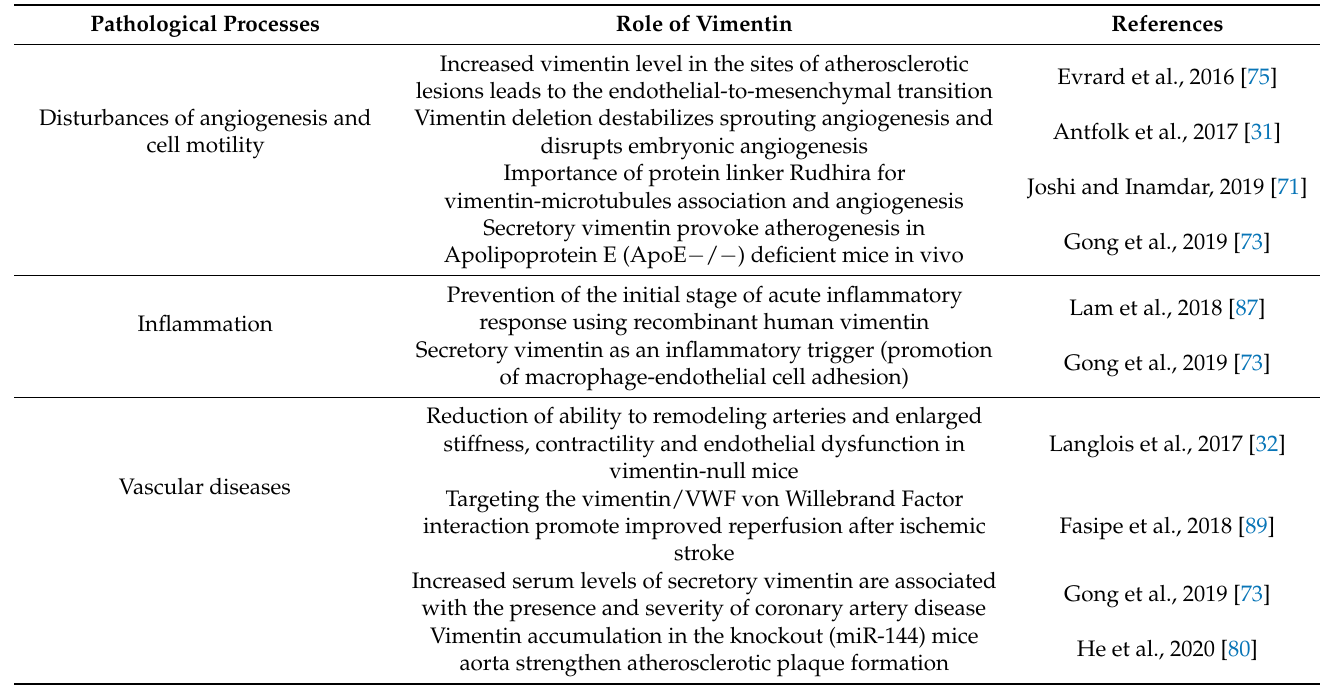
Table 1. Vimentin in the development of angiogenetic, inflammatory, and vascular pathologies. Pathological